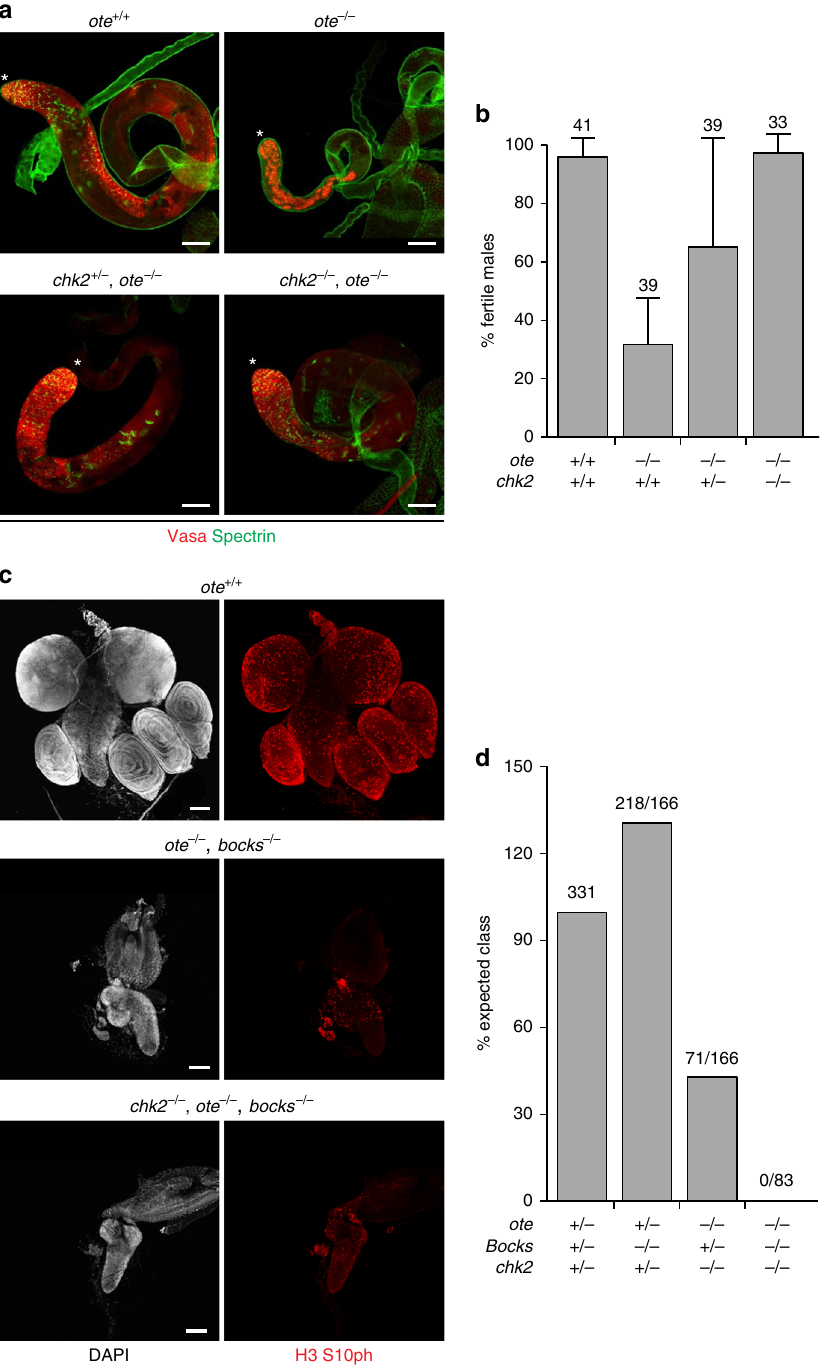
Fig. 7 Checkpoint inhibition rescues male GSC, but not somatic defects in ote mutants. a Confocal images of testes from 6-day-old males stained for Vasa (red) and Spectrin (green). Genotypes are noted above the images. The GSC niche is denoted by an asterisk. b Percentage of fertile 12 – 15-day-old males mated to ote + / + virgin females. Males were determined to be fertile if greater than 5 offspring were produced over a 3-day mating period as described in ref. 16 . Genotypes are noted below, and the number of males analyzed is noted above each data set. Error bars indicate the standard deviation from a minimum of three independent experiments. c Confocal images of the central nervous system and surrounding imaginal discs dissected from wandering third instar larvae stained for DAPI (gray) and antibodies against phosphorylated serine 10 of Histone H3 (H3 S10ph; red). Genotypes are noted above each image. All scale bars are 100 µ m. d Percent expected class from the following cross: y 1 ,w 67c23 ; chk2 P6 ,ote PK /CyO; bocks Δ 66 /Tm6b,Tb 1 crossed to y 1 ,w 67c23 ; chk2 P30 ,ote B279G /CyO; bocks Δ 10 /Tm6b,Tb 1 . The genotype of the progeny is noted below and the number of progeny eclosed over the expected number